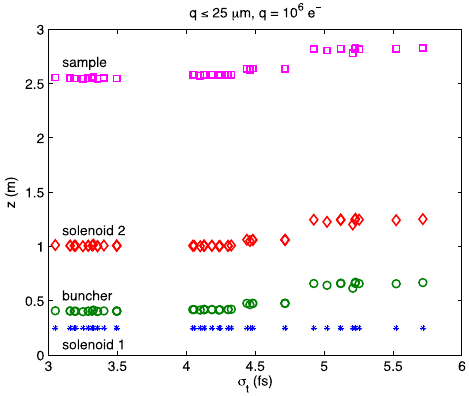
FIG. 4. Optimal coherence length as a function of bunch length at the sample for a final beam spot size of σ x ≤ 25 μ m.